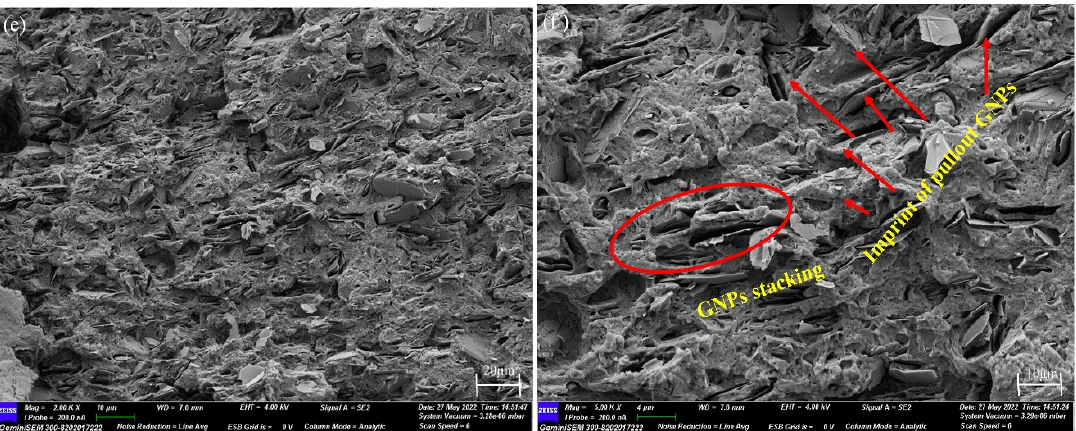
Figure 5. SEM images of tensile-fractured-specimen surface of ( a , b ) neat ABS; ( c , d ) ABS+GNP3; and ( e , f ) ABS+GNP15 nanocomposites.